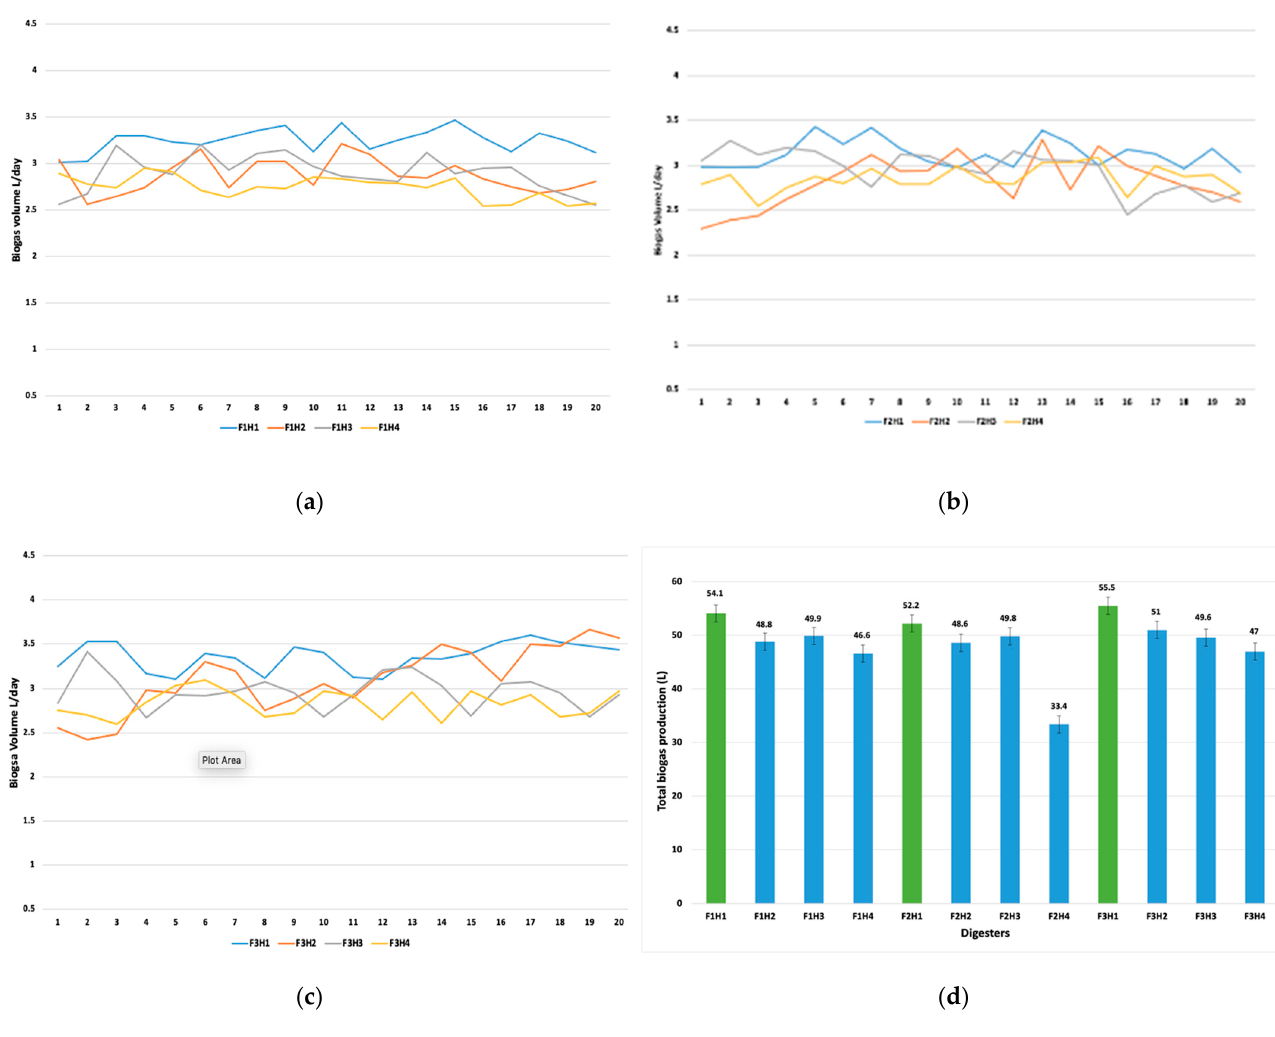
Figure 3. Represents the daily biogas production for continuous 20 days at different mixing intervals. ( a ) for digester 1, ( b ) for digester 2, and ( c ) for digester 3, respectively. ( d ) represents the overall biogas production from all three digesters. Table 2. Comparison of biogas production from all three digesters under similar working conditions.